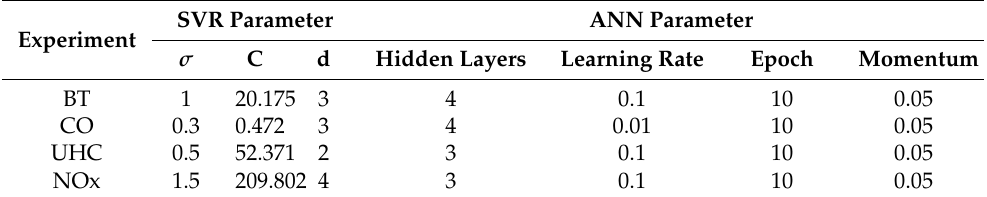
Table 6. Parameters of SVR and ANN models. SVR Parameter ANN Parameter Experiment Hidden Layers Learning Rate